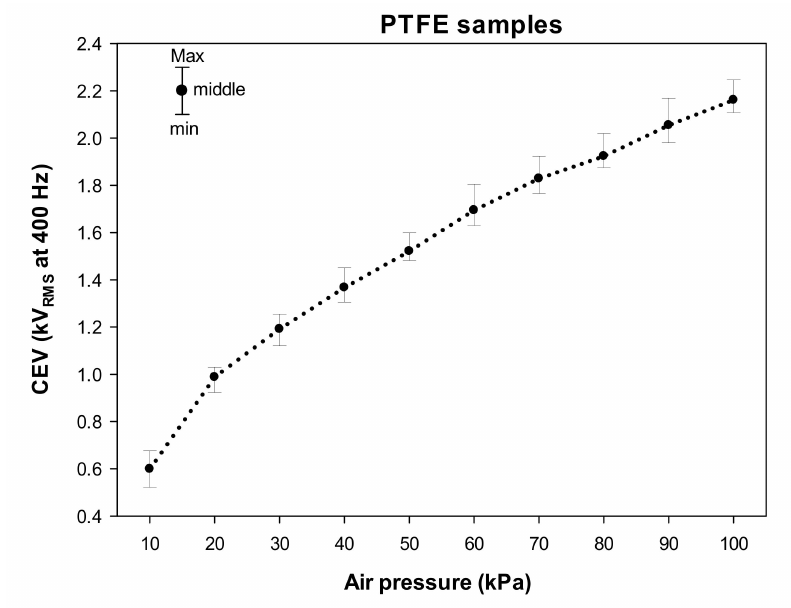
Figure 4. CEV values measured at 400 Hz of the analyzed PTFE samples (three replicas each) in the 10–100 kPa interval covering the aeronautic pressure range.